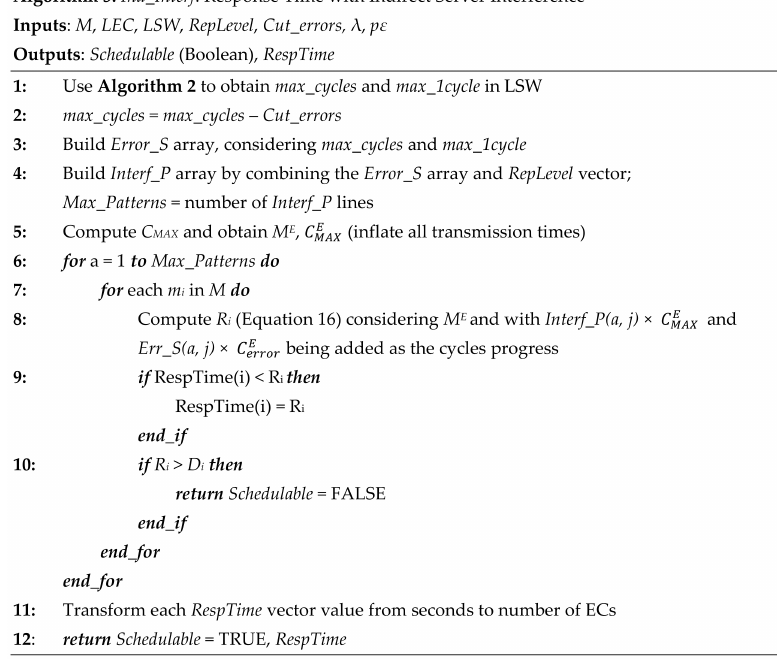
Figure 8. Possible error and recovery scenarios for indirect